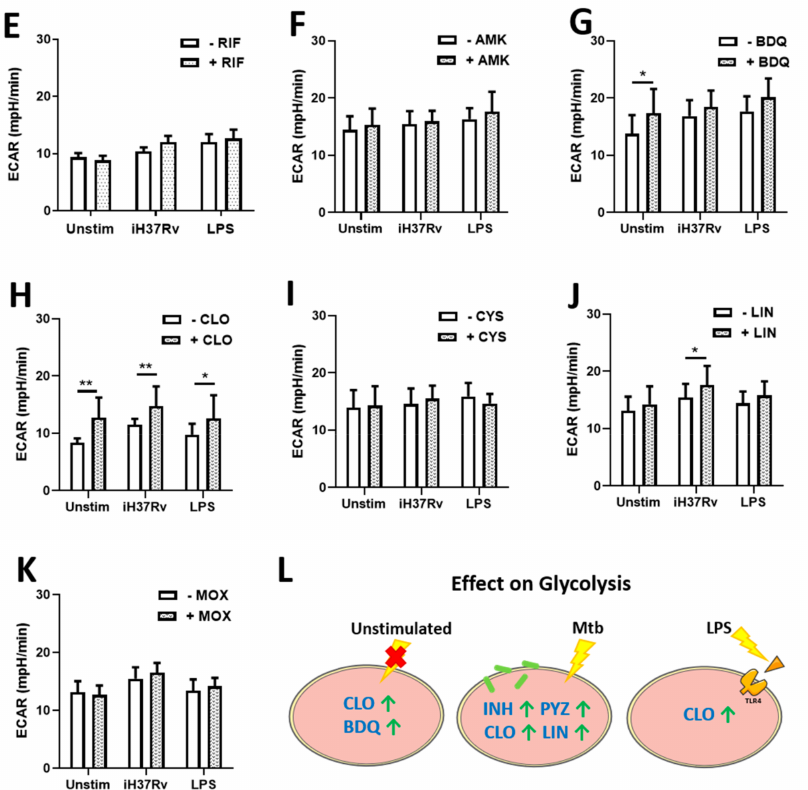
Figure 1. Isoniazid, pyrazinamide, bedaquiline, clofazimine and linezolid increase glycolytic profiles in unstimulated, iH37Rv-Mtb-stimulated and LPS-stimulated hMDMs. ( A ) Illustrative heat map showing changes in ECAR in response to treatment with first-line (top) and second-line (bottom) TB antimicrobials. hMDMs, differentiated from PBMCs isolated from healthy blood donors, were treated with ( B ) ethambutol (5 µ g/mL), ( C ) isoniazid (1 µ g/mL), ( D ) pyrazinamide (2 µ g/mL), ( E ) rifampicin (2 µ g/mL), ( F ) amikacin (5 µ g/mL), ( G ) bedaquiline (5 µ g/mL), ( H ) clofazimine (2 µ g/mL), ( I ) cycloserine (5 µ g/mL), ( J ) linezolid (15 µ g/mL) or ( K ) moxifloxacin (12.5 µ g/mL) three hours post stimulation with either iH37Rv-Mtb or LPS (100 ng/mL). 24 h post stimulation, ECAR profiles, representing glycolysis, were determined utilising the Seahorse Extracellular Flux Analyser. ( L ) Summary of how the antimicrobials affect glycolytic profiles in unstimulated, iH37Rv- Mtb-stimulated and LPS-stimulated hMDMs. Bars denote mean ± SEM * p < 0.05 and ** p < 0.01 (Two-way repeated measures ANOVA with Sidak’s multiple comparisons test). Ethambutol (EMB, n = 7); isoniazid (INH, n = 8); pyrazinamide (PYZ, n = 7); rifampicin (RIF, n = 9); amikacin (AMK, n = 5); bedaquiline (BDQ, n = 6); clofazimine (CLO, n = 6); cycloserine (CYS, n = 4); linezolid (LIN, n = 8); moxifloxacin (MOX, n =